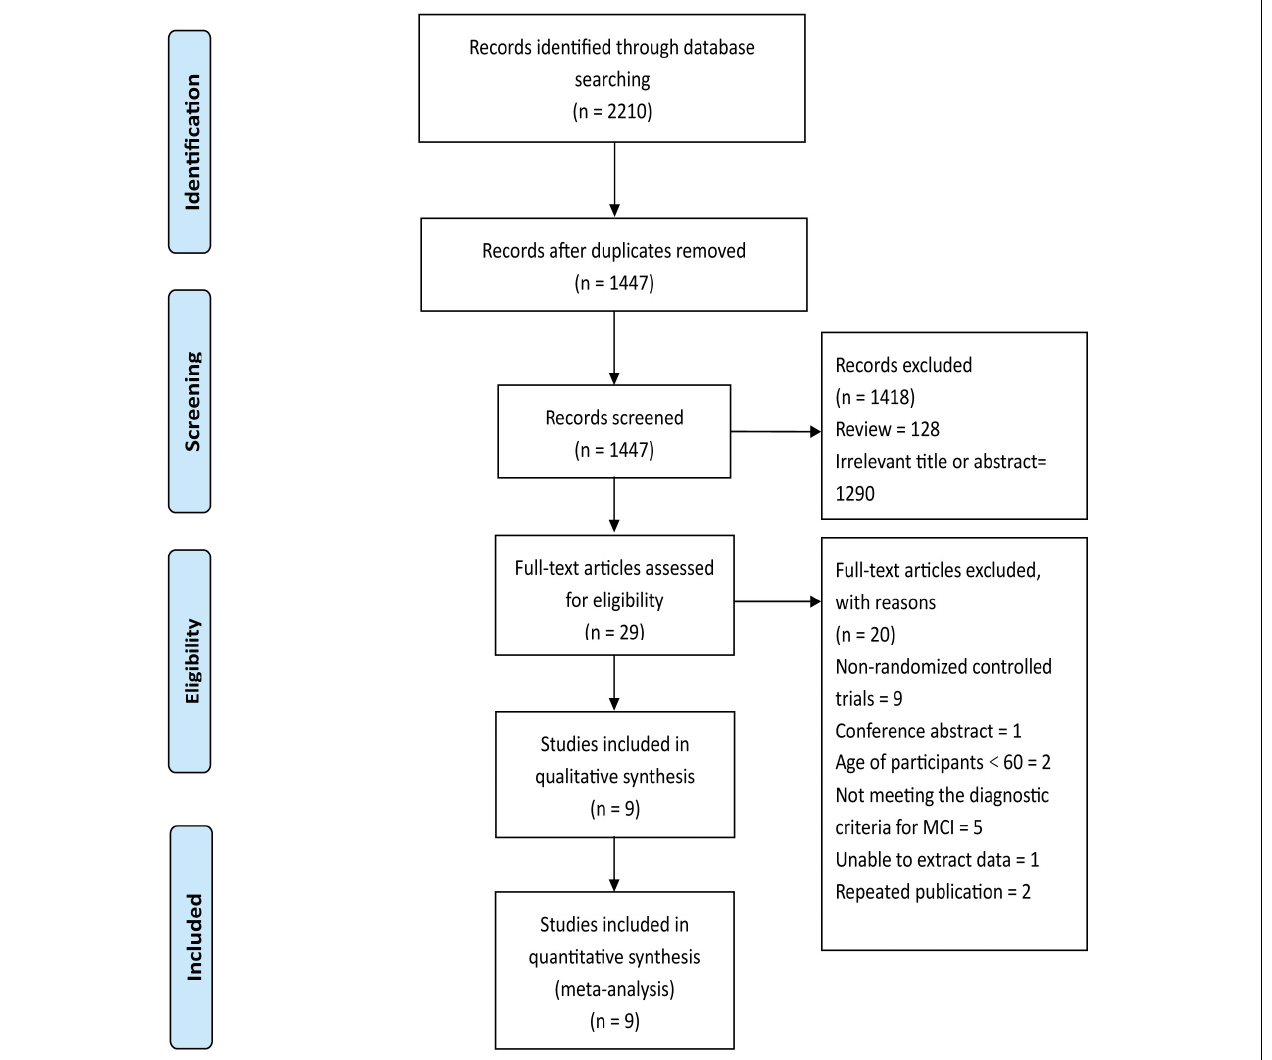
FIGURE 1 | Flow chart for selection of